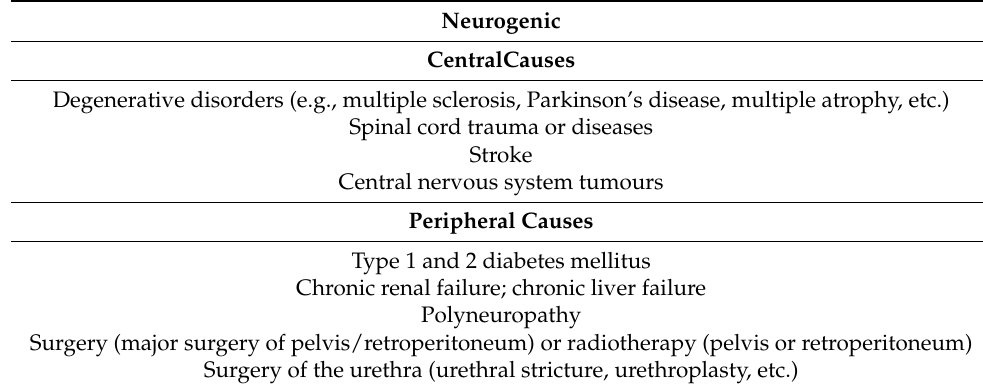
Table 1. Etiological factors of neurogenic erectile dysfunction